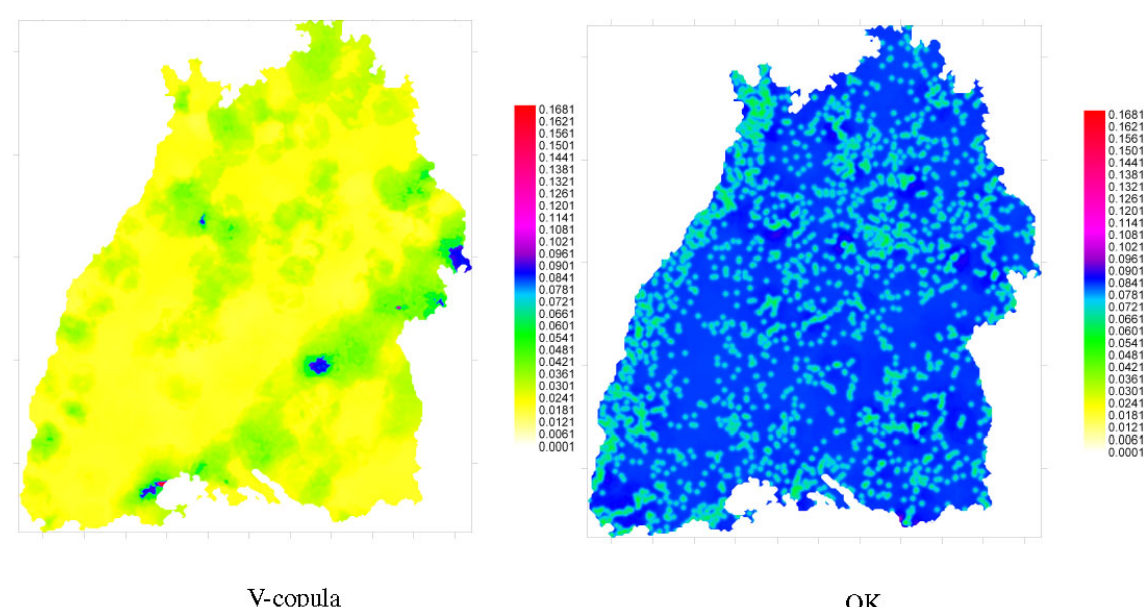
Fig. 11. Uncertainty maps for deethylatrazin: left the length of the 80% confidence interval obtained via v-copula based interpolation, right the kriging standard deviation obtained by